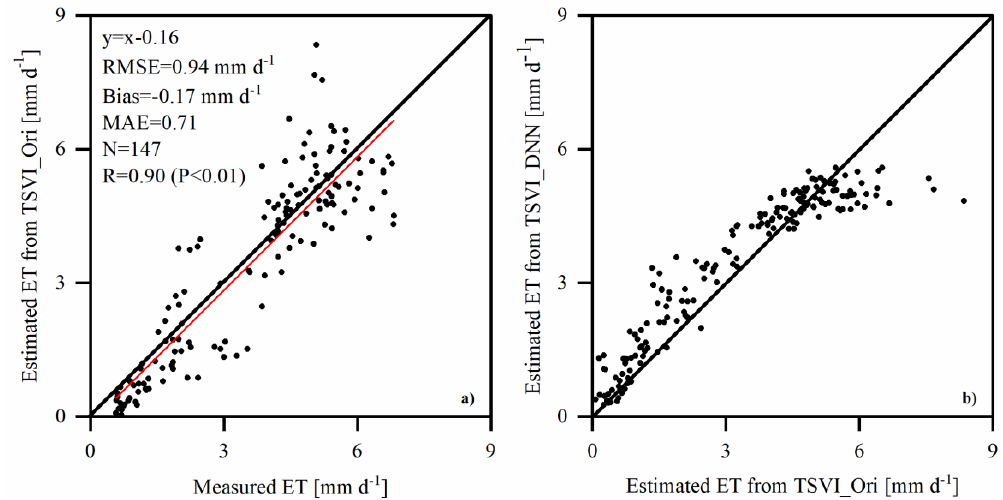
Figure 4. Comparison of evapotranspiration (ET) estimates from the TSVI_DNN and TSVI_Ori models at the YK station during 2009-2011. (a) A scatterplot of ET estimates from the TSVI_Ori model vs. measured ET; (b) a scatterplot of ET estimates from TSVI_Ori vs. TSVI_DNN.